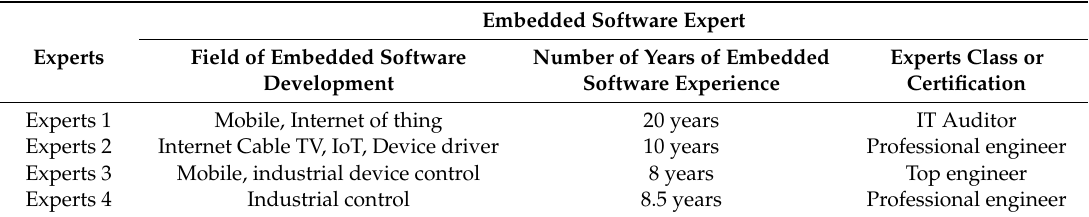
Table 6. Four embedded software experts involved in terms standardization.